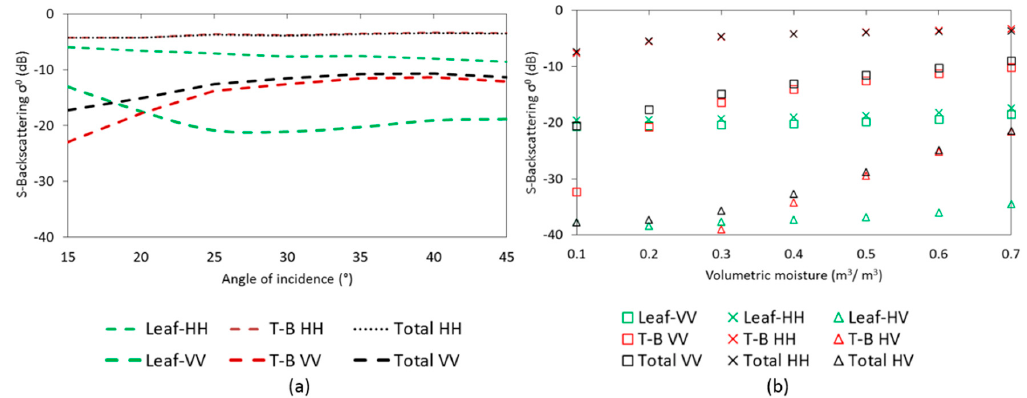
Figure A1. S-band backscatter vs. canopy parts ( a ) at 0.5 volumetric moisture (m 3 /m 3 ) across incidence angles and ( b ) at varying volumetric moisture (m 3 /m 3 ) at 30° radar range where T- and B- represents trunk and branches respectively.